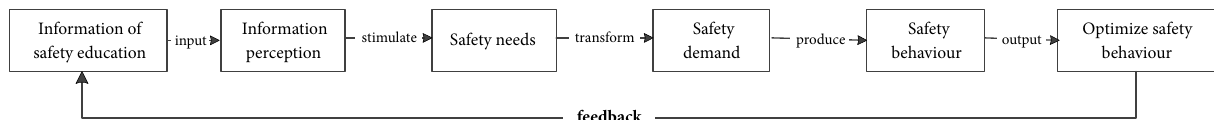
Figure 4. Implementation process of safety education